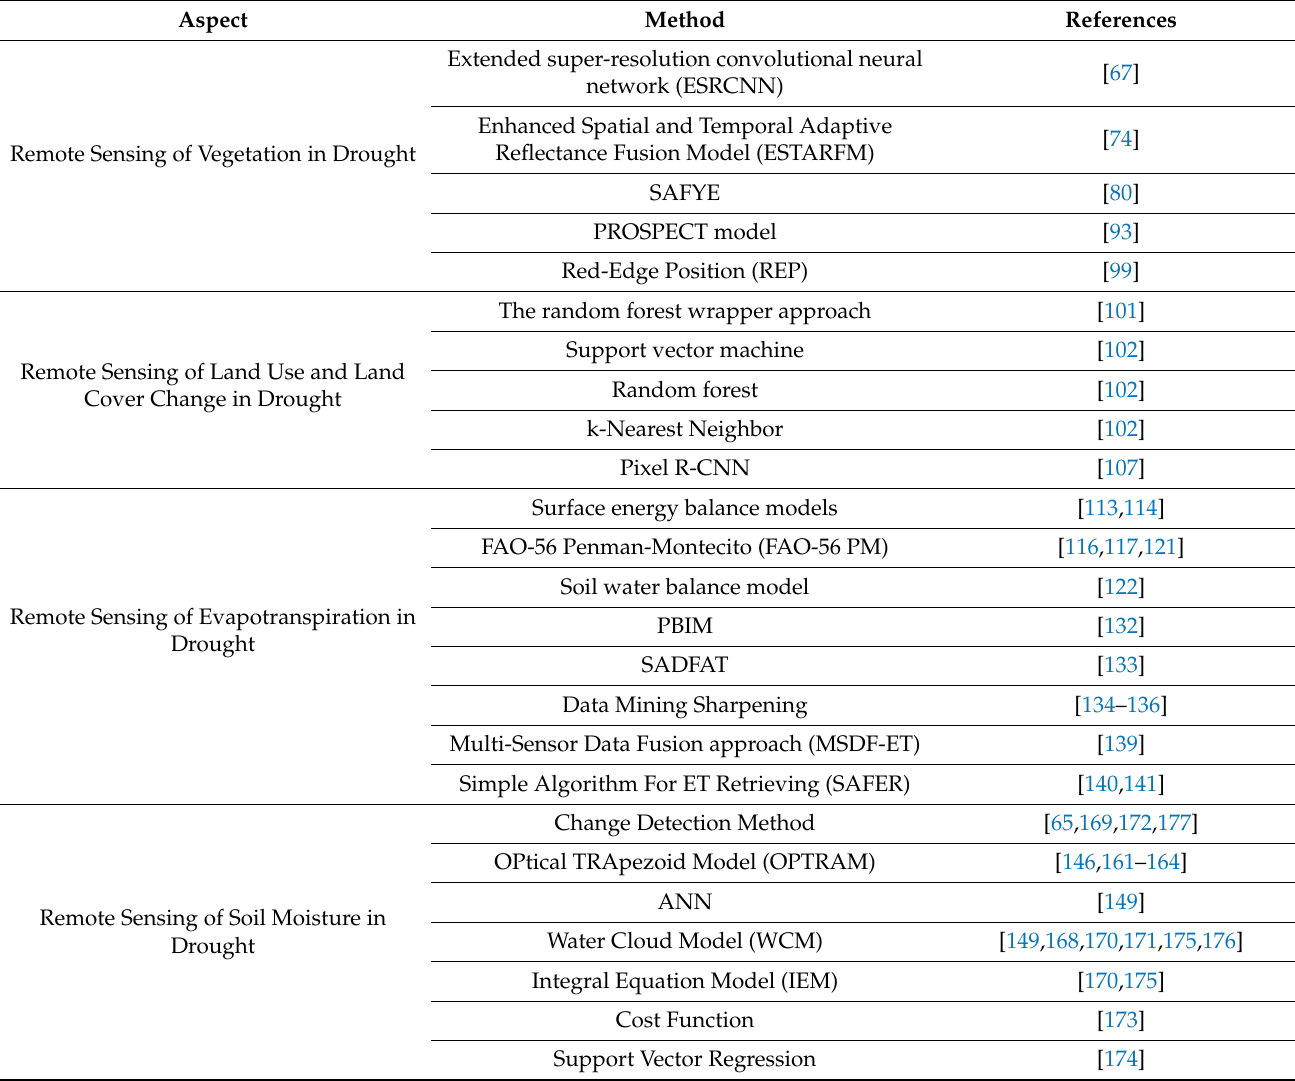
Table 2. Summarized methods for extracting drought information from Sentinel-2.